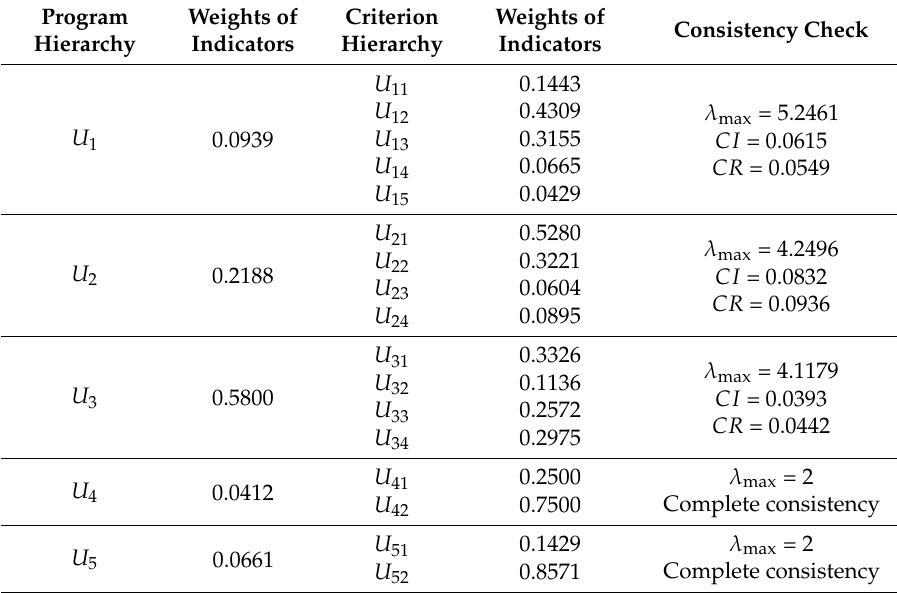
Table 5. Subjective weights of energy saving and emission reduction evaluation indicators